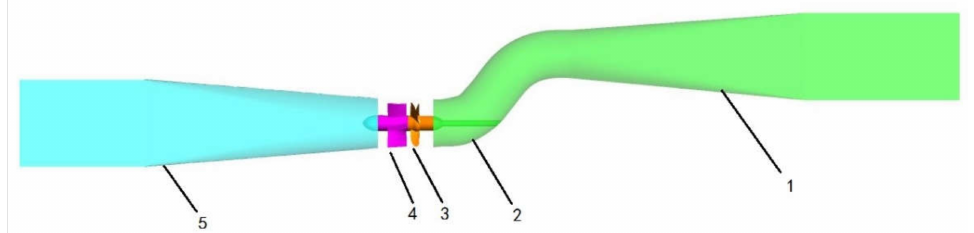
Figure 1. Model diagram of S-type front shaft extension tubular pump device. (1). Inlet channel. (2). S-elbow pipe. (3). Impeller. (4). Guide vane body. (5). Outlet channel.